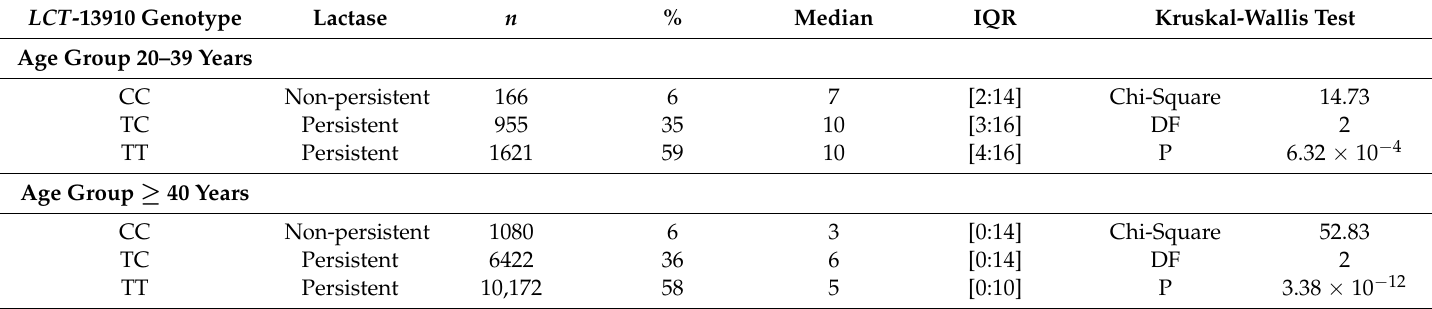
Table 4. Differences in milk intake, glasses per week, by the LCT-13910 C/T